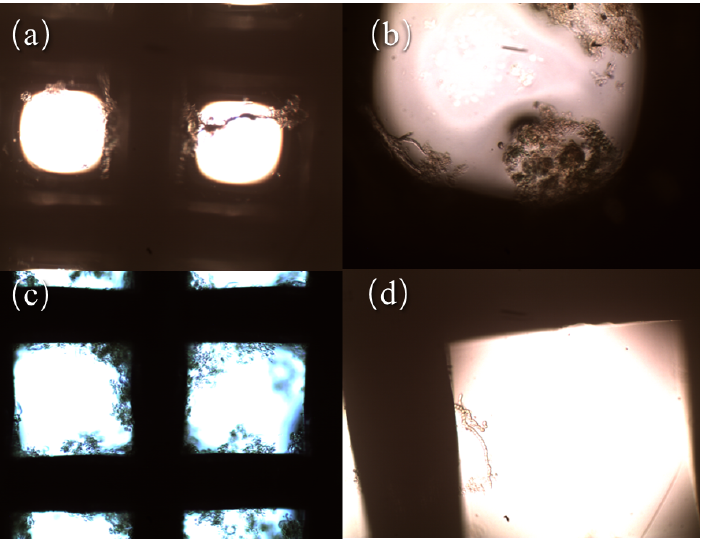
Figure 2. Microscopic images of Anabaena captured by the mesh electrodes in the DEP process: ( a ) filamentous Anabaena captured by 30-mesh electrodes; ( b ) agglomerated Anabaena captured by 30-mesh electrodes; ( c ) Anabaena clusters captured by 80-mesh electrodes; ( d ) single bead-shaped Anabaena captured by 80-mesh electrodes.